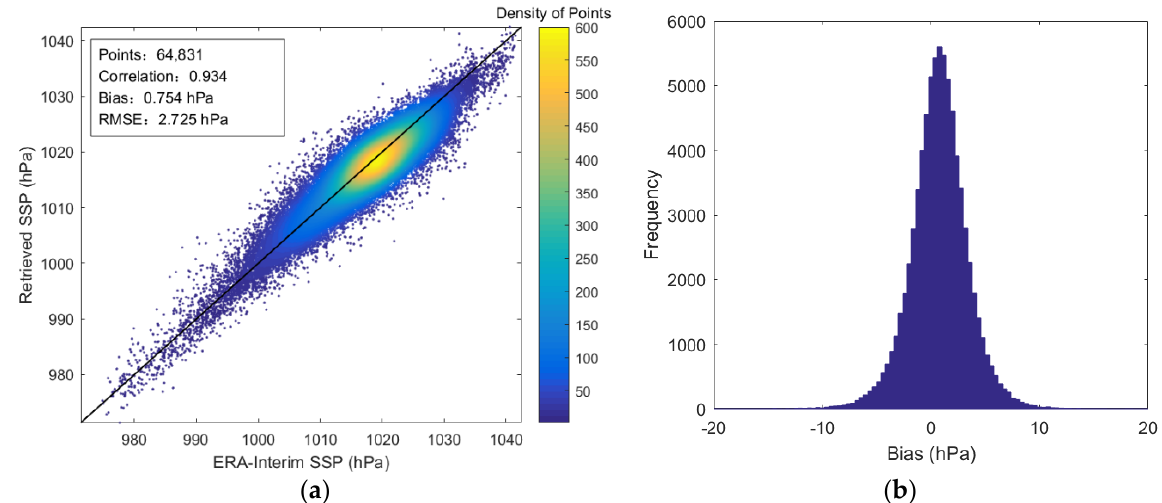
Figure 10. The SSP retrieval results and the distribution of retrieval bias from MWTS-II: ( a ) the retrieval results; ( b ) the distribution of bias.